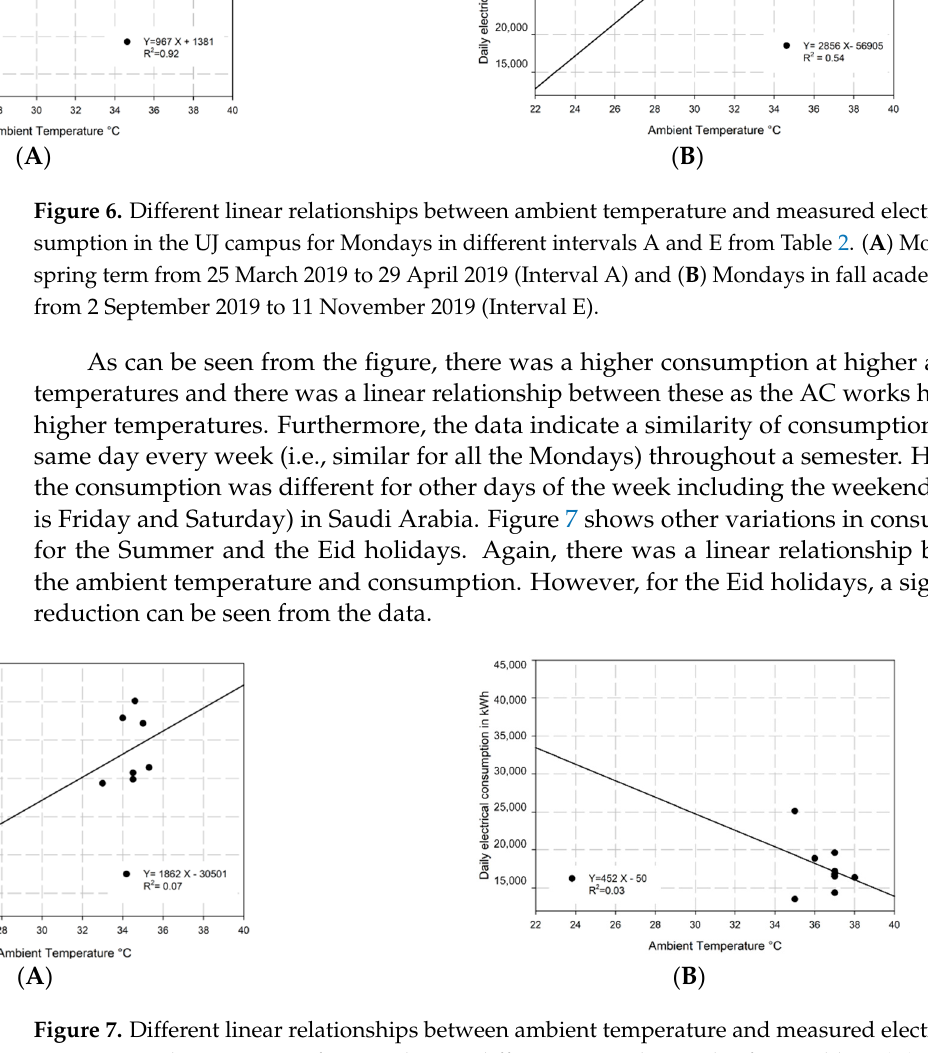
Figure 7. Different linear relationships between ambient temperature and measured electrical con- sumption in the UJ campus for Mondays in different intervals B and C from Table 2. ( A ) Mondays in Summer holiday from 6 May 2019 to 26 August 2019 (Interval B); ( B ) days in Eid Alfitr holiday including two Mondays, 30 May 2019 to 8 June 2019 (Interval C).